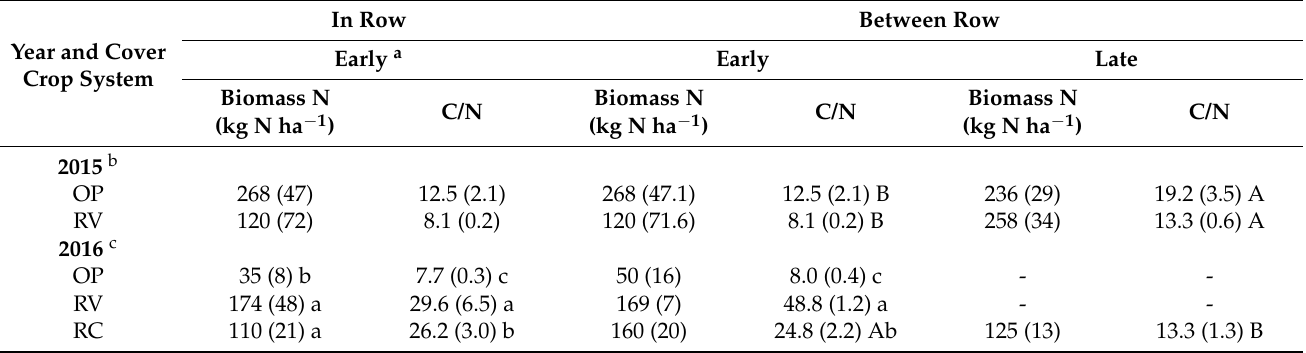
Table 2. Mean cover crop system aboveground biomass N and C/N by year, soil region, and sampling time in 2015 and 2016. Numbers in parentheses represent one standard error. Different capital letters in a row within a region denotes a significant main effect of sampling time ( p < 0.05). Different lowercase letters in a column denotes a significant main effect of cover crop system ( p <